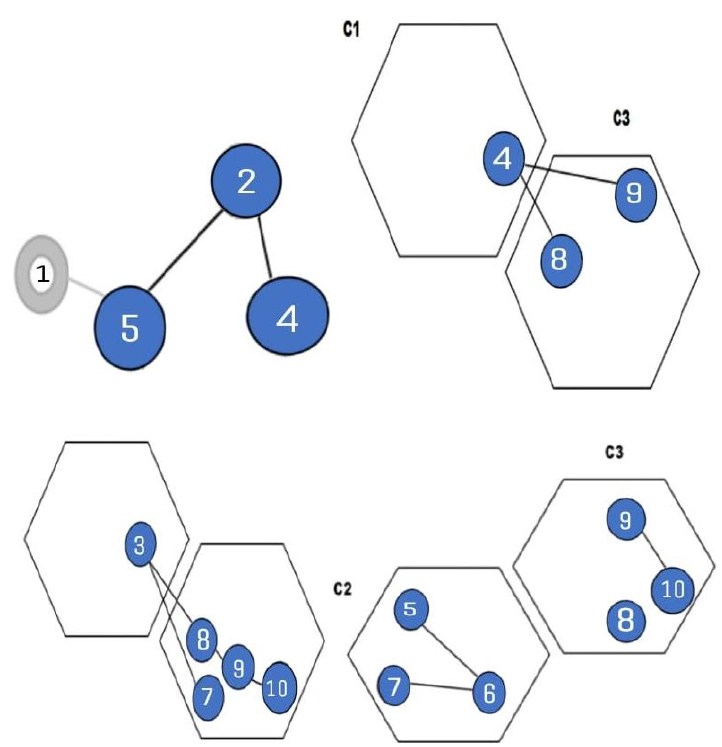
Figure 5. Tree Scenario Cluster — Single and Multiple Clusters. Inter- and Intra-Cluster Tree Scenario.